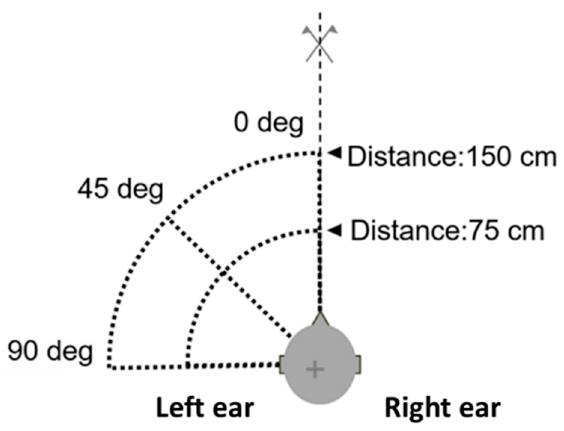
Figure 5. Monopole source positioning for the experimental measurements. Table 1. Experimental test matrix.